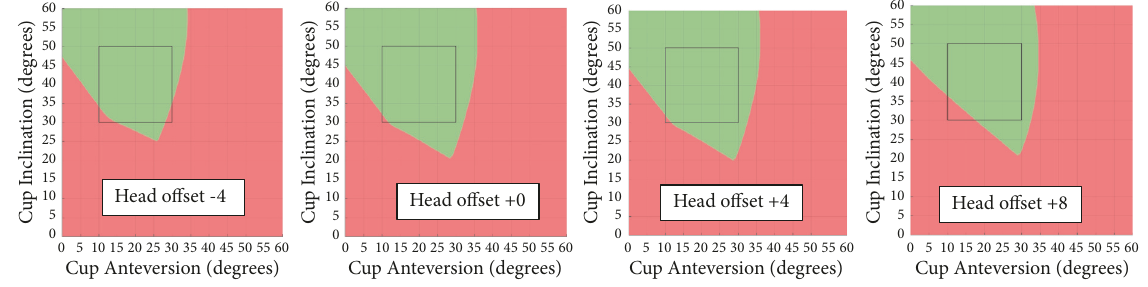
Figure 7: Impingement with different head offset for stem